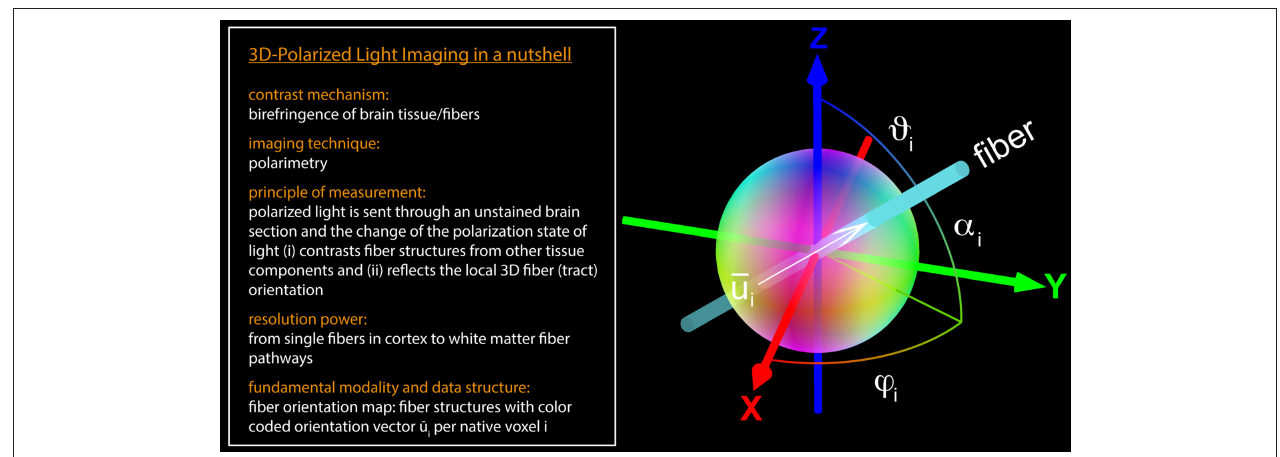
FIGURE 1 | 3D-PLI in a nutshell. The fiber orientation vector −→ u i located at the native voxel location i is defined by the direction angle ϕ i and the inclination angle α i . The brain section is aligned to the x-y-plane (at z = 0 ). In general, a unit vector can be described as a distinct point on a unit sphere. For 3D-PLI, the determined unit vector represents an axis in space (in the mathematical and the anatomical sense), since the initial and the terminal points cannot be assigned uniquely. Therefore, the point reflection across the center of the sphere has to be assigned to the same vector. For visualization purposes, the vectors were encoded in RGB color space: the x-component of −→ u i is represented by the red color channel (R), the y-component by the green color channel (G), and the z-component by the blue color channel